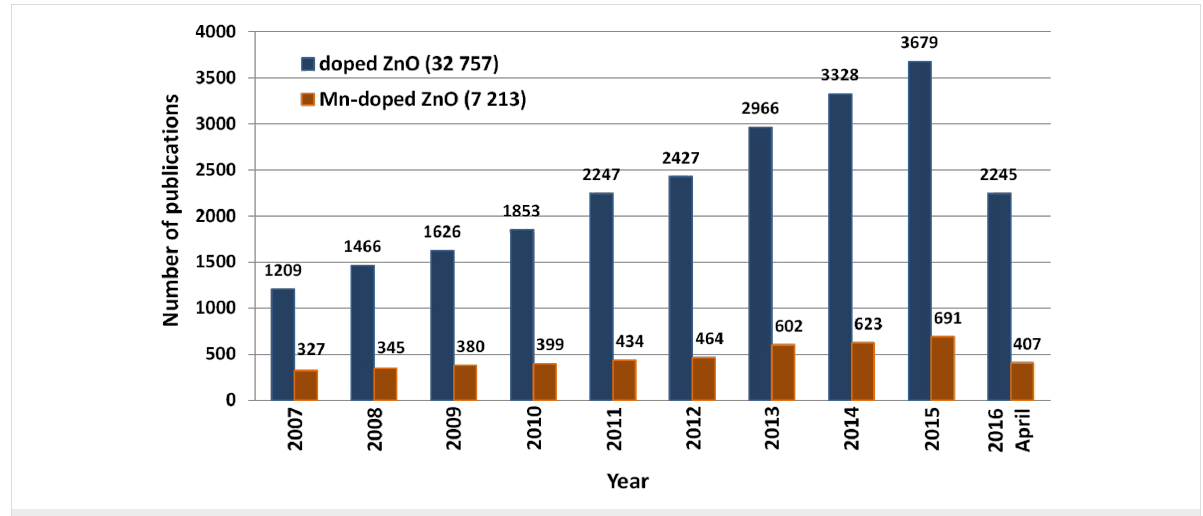
Figure 1: The number of scientific publications referring to the search of “doped ZnO” and “Mn doped ZnO” phrases published in the period 2007–2015. Source: ScienceDirect (accessed April 27, 2016).